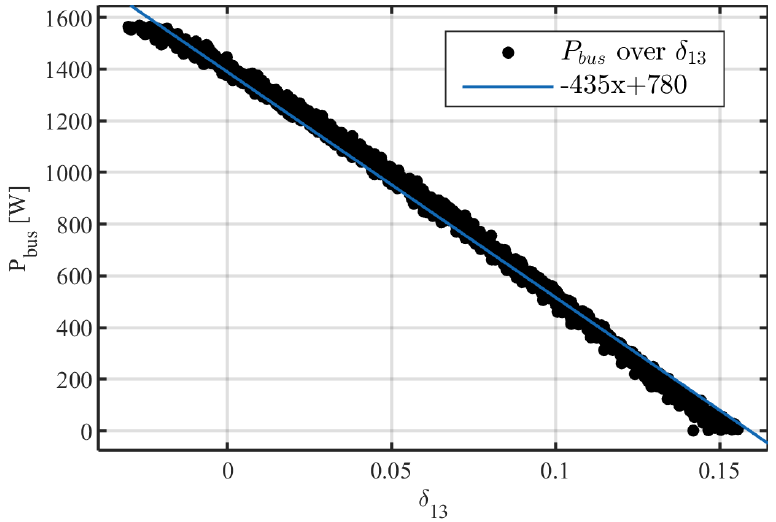
Figure 11. Power to load transfer over δ 13 , keeping MPPT. Therefore, the MPPT control loop cycles have been defined as shown in the flow chart of Figure